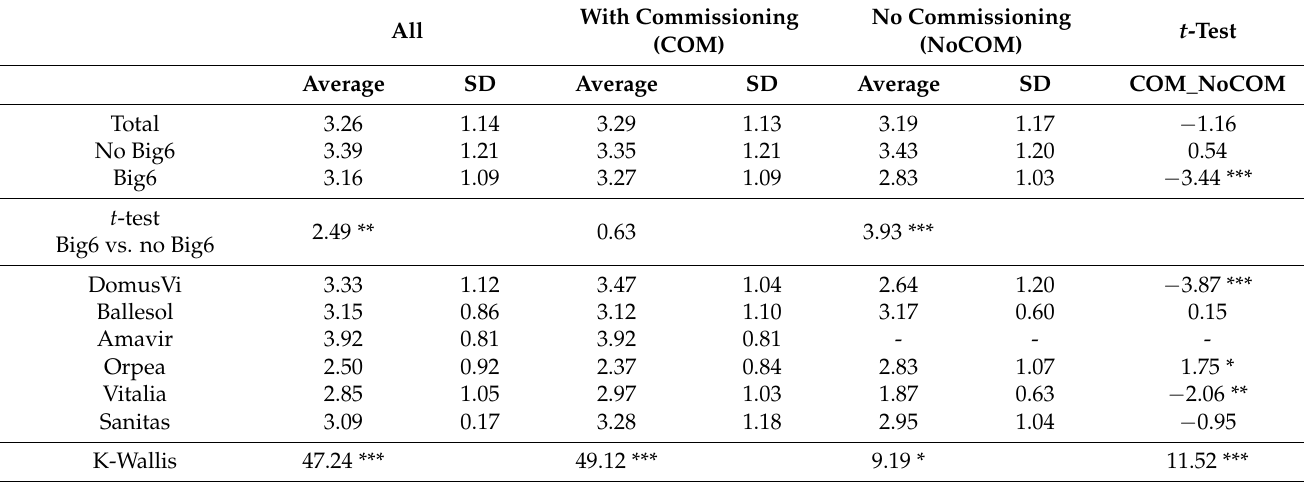
Table 2. Descriptives.